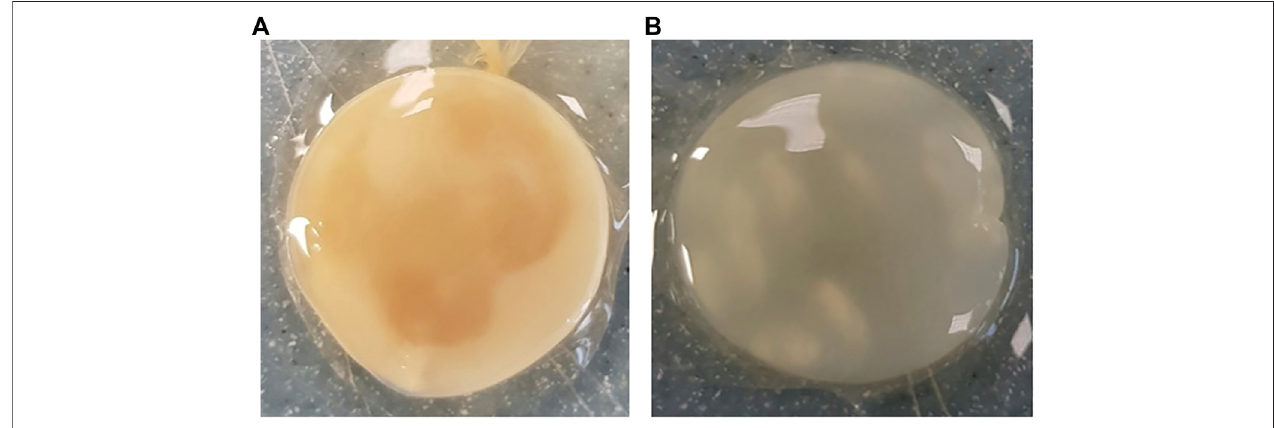
FIGURE 2 | Examples of pellicles (approx. 2 cm across) produced in generation 2 from KSC (A) and the K. xylinus isolate (B) .